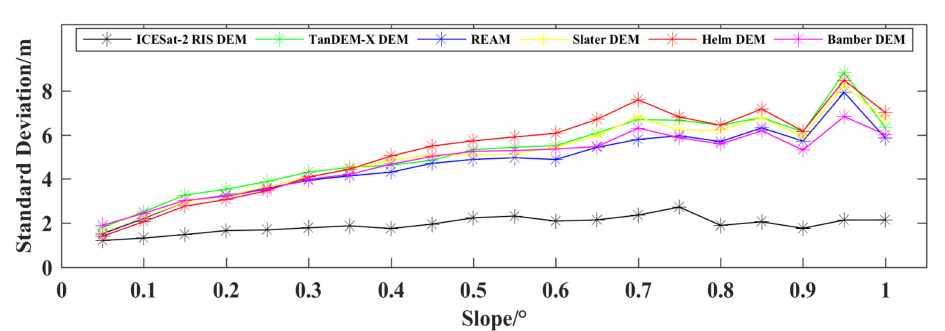
Figure 11. Standard deviations between ICESat-2 RIS DEM as well as the five Antarctic DEMs and OIB elevations. The horizontal coordinate is the slope of the surface from 0 ◦ to 1 ◦ with an interval of 0.05 ◦ .